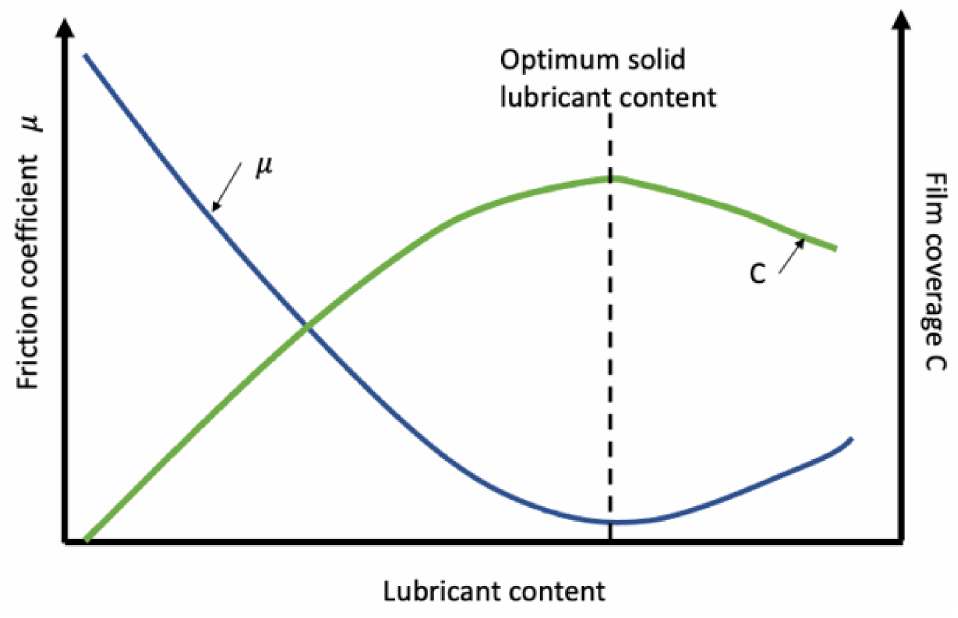
Figure 17. Relationship between film coverage and friction coefficient as a function of solid-lubricant content for MoS 2 films